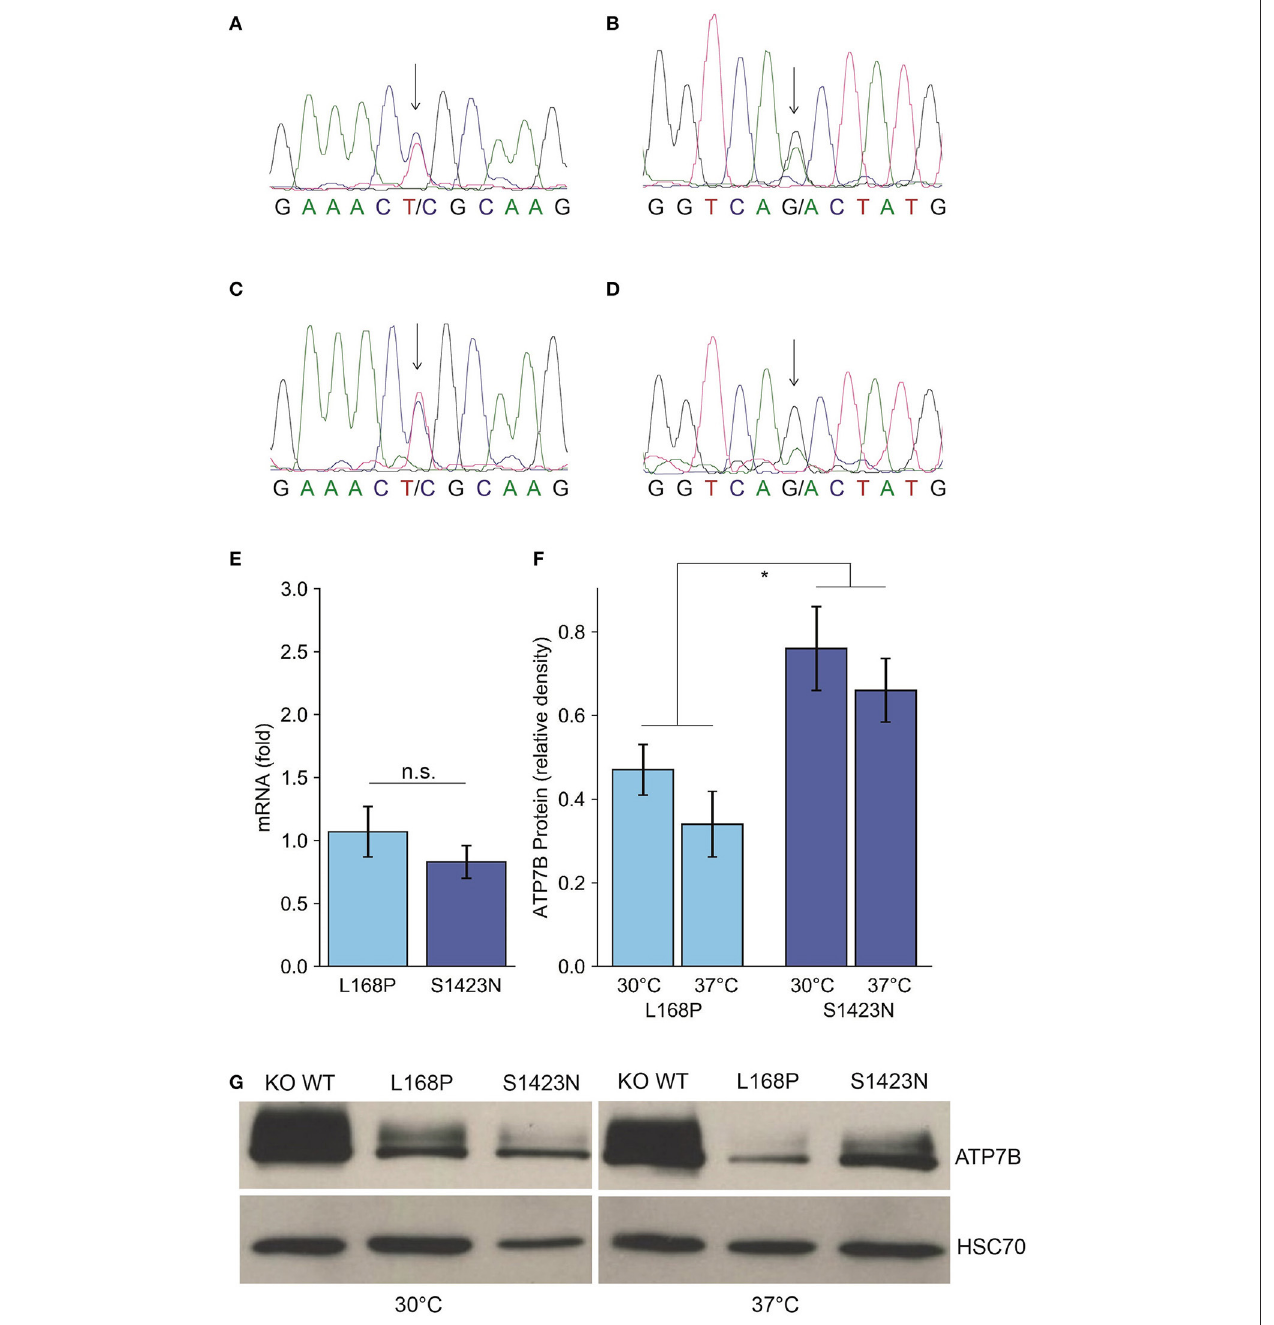
FIGURE 1 | Identification and expression of ATP7B mutants p.L168P and p.S1423N. (A , B) Sequence analysis of the patient shows a compound heterozygote p.L168P (A) and p.S1423N (B) mutation. (C , D) The respective sequences derived from the father (C) and mother (D) are also depicted. (E) ATP7B mRNA expression of both variants was determined by RT-qPCR analysis. Mean/SE are given ( n = 3). (F) Densitometry determination of ATP7B protein expression relative to wild type is shown. Mean/SE are given ( n = 3). * P < 0.05. (G) One typical Western blot is